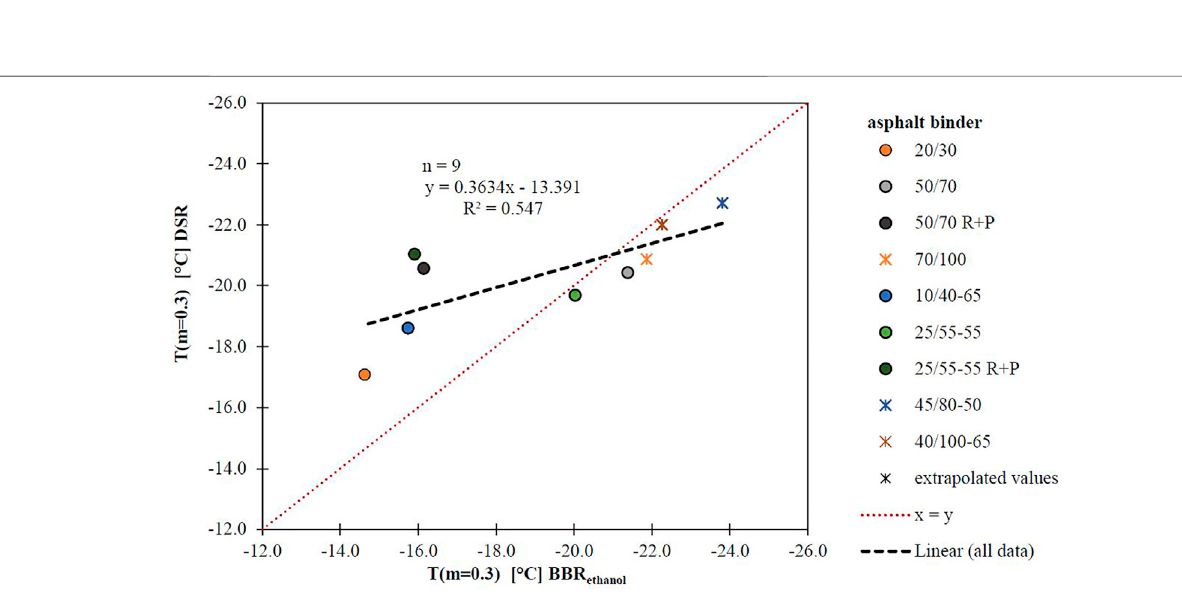
Frontiers in Materials |